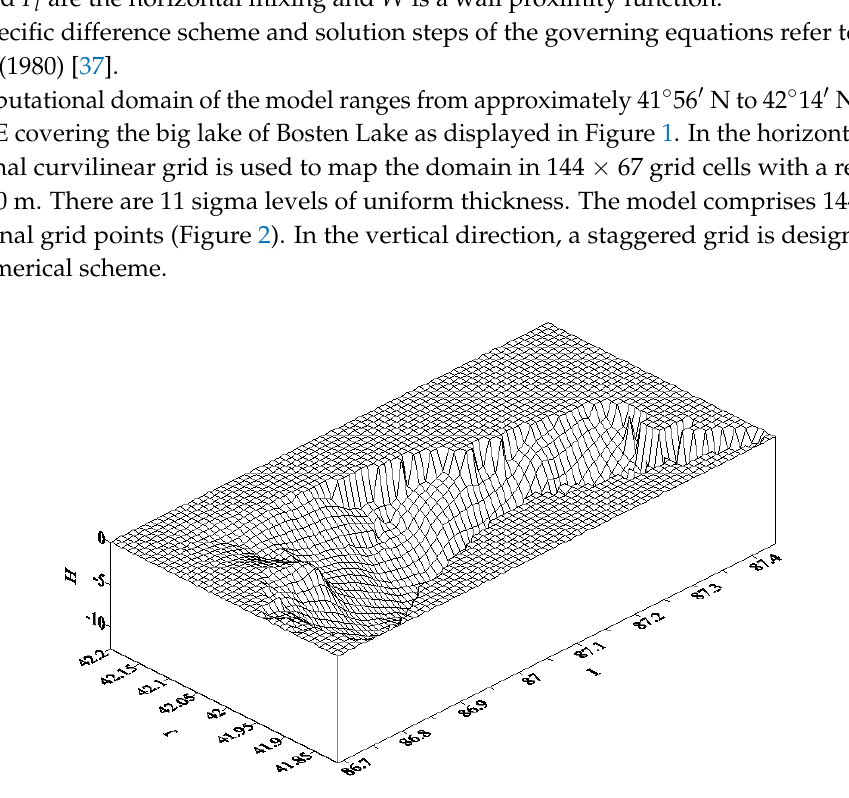
Figure 2. The computational grids for the model showing every second model grids point.